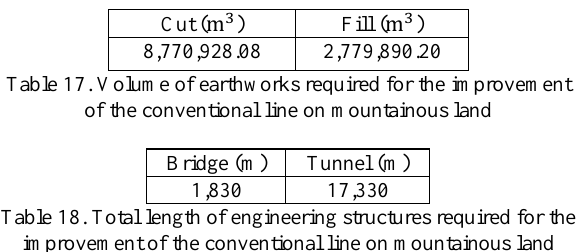
Table 18. Total length of engineering structures required for the improvement of the conventional line on mountainous land